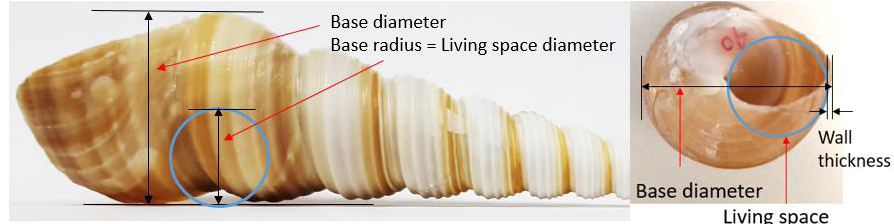
Figure 8. Diagram showing the different measurements used for base diameter and living space.